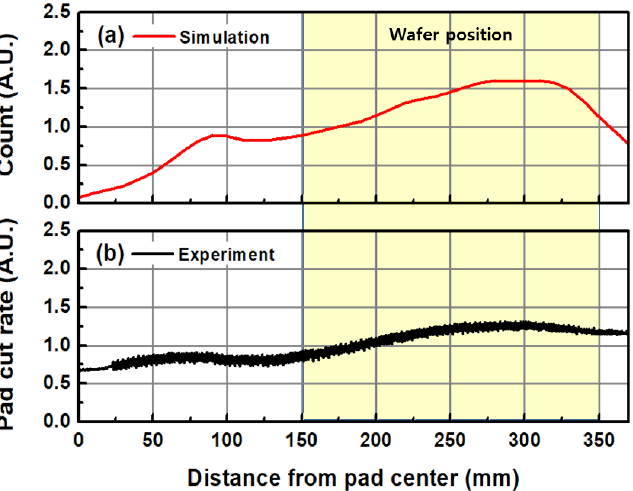
Figure 10. Normalized pad cut rate profile of Case I: ( a ) simulation result and ( b ) experimental result.